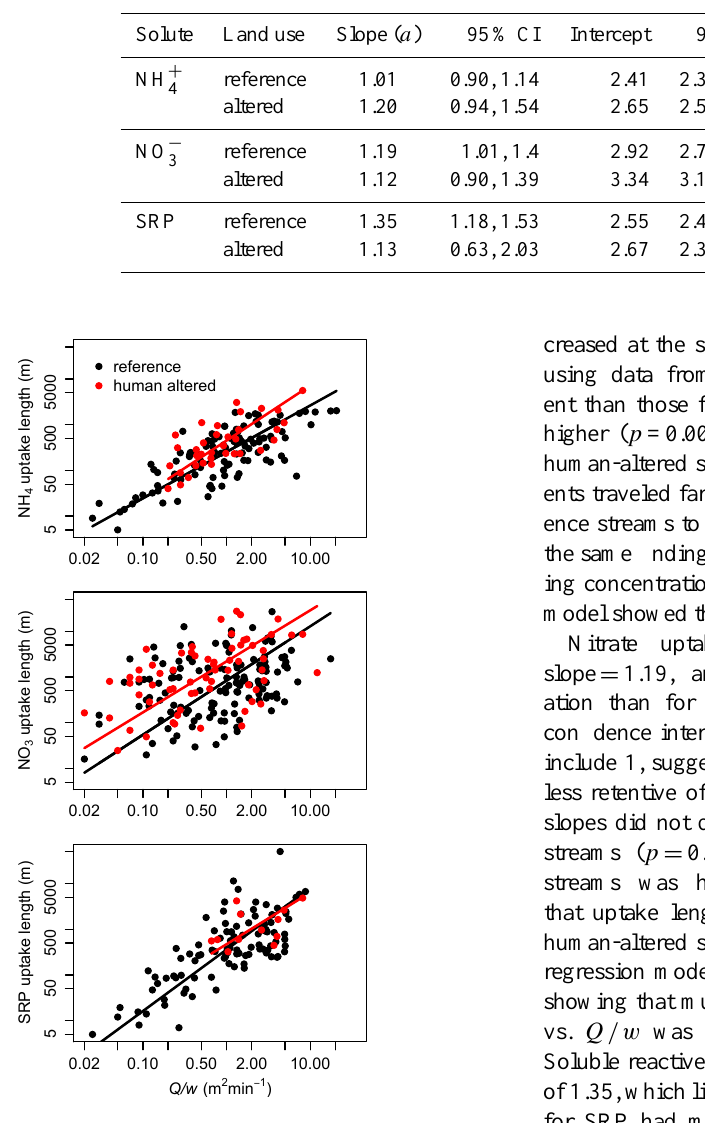
Fig. 1. Nutrient uptake length scaled isometrically for ammonium ) , and allometrically for nitrate ( S w − NO ) and soluble re- ( S w − NH 4 3 active phosphorus ( S w − SRP ) as a function of stream-specific dis- charge ( Q/w) . Points are data from individual streams and lines are standardized major axis regression lines fit through the data. Red points are streams with substantial human land use alteration in the watershed. Black points are reference streams. Parameters for re- gression equations are in Table